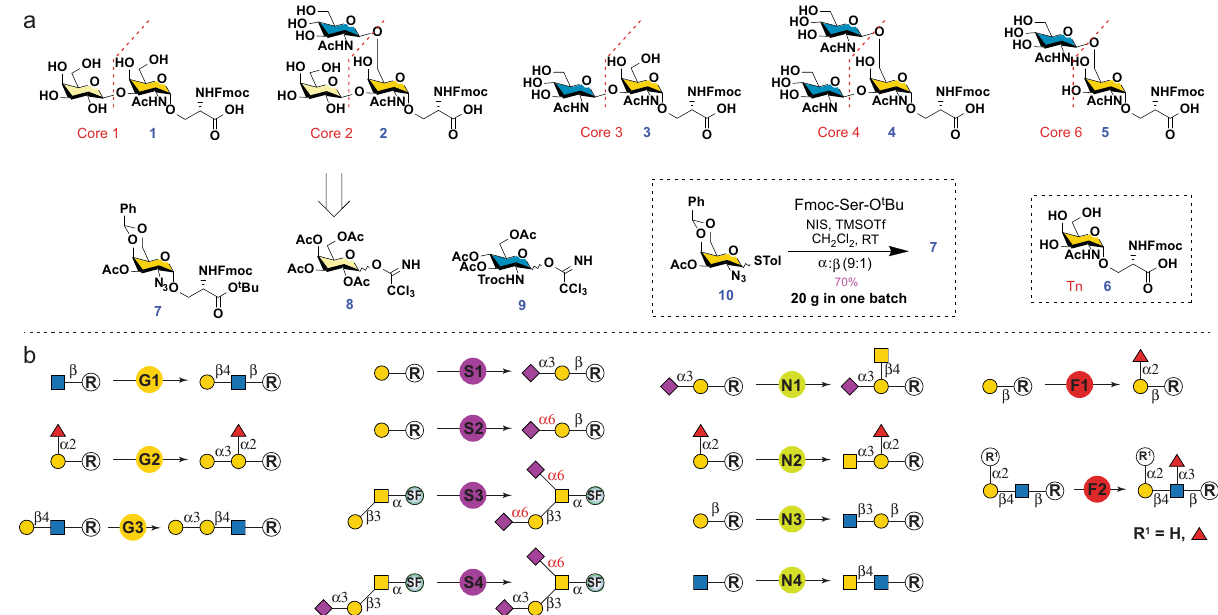
Fig. 2 Retrosynthetic analysis of O-GalNAc glycans. a Retrosynthetic analysis of O-GalNAc cores with three synthetic building blocks. b Retrosynthetic analysis of O-GalNAc epitopes with 13 enzyme modules. Enzyme modules: G stands for galactosylation, S stands for sialylation, N stands for N -acetylhexosaminylation, F stands for fucosylation. G1: β 1-4 galactosylation with Neisseria meningitidis β 1-4 galactosyltransferase (NmLgtB) 47 and donor uridine 5 ′ -diphosphogalactose (UDP-Gal); G2: α 1 – 3 galactosylation with human GTB and UDP-Gal; G3: α 1-3 galactosylation with bovine α 1-3 GalT (B α 3GalT) 48 and UDP-Gal; S1: α 2-3 sialylation with Pasteurella multocida α 2-3 sialyltransferase 1 mutant M144D (PmST1-M144D) 52 , N. meningitidis CMP-sialic acid synthetase (NmCSS) 69 , cytidine 5 ′ -triphosphate (CTP), and N -acetylneuraminic acid (Neu5Ac); S2: α 2-6 sialylation with PmST1-P34H/ M144L 49 , NmCSS, CTP, and Neu5Ac; S3: α 2 – 6 sialylation with Photobacterium damselae α 2 – 6 sialyltransferase (Pd2,6ST) 50 , NmCSS, CTP, and Neu5Ac; S4: α 2-6 sialylation with human ST6GalNAc-IV, NmCSS, CTP, and Neu5Ac; N1: β 1-4 N -acetylgalactosaminylation with Campylobacter jejuni β 1-4 N -acetylgalatosaminyltransferase (CjCgtA) 70 and uridine 5 ′ -diphosphate- N -acetylgalactosamine (UDP-GalNAc); N2: α 1-3 N -acetylgalactosaminylation with Helicobacter mustelae α 1-3 N -acetyl-galactosaminyltransferase (HmBgtA) 56 and UDP-GalNAc; N3: β 1-3 N -acetylglucosaminylation with Helicobacter pylori β 1-3 N -acetylglucosaminyltransferase (HpLgtA) 71 and uridine 5 ’ -diphosphate- N -acetylglucosamine (UDP-GlcNAc); N4: β 1-4 N - acetylgalactosaminylation with b4GalT-Y289L/C342T (b4GalTm) 72 and UDP-GalNAc; F1: α 1-2 fucosylation with H. mustelae α 1-2 fucosyltransferase (Hm2FT) 55 and guanosine 5 ′ -diphospho-L-fucose (GDP-Fuc); F2: α 1-3 fucosylation with H. pylori α 1-3 fucosyltransferase C-terminal 66 amino acid truncation (Hp3FT) 73 and GDP-Fuc. SF, Fmoc protected